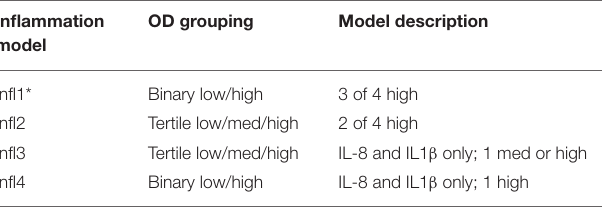
TABLE 1 | Final inflammation models based on cytokine interleukin (IL)-1 β , IL-8, CXCL10, and tumor necrosis factor- α (TNF- α ) optical density (OD) results in tertile or binary